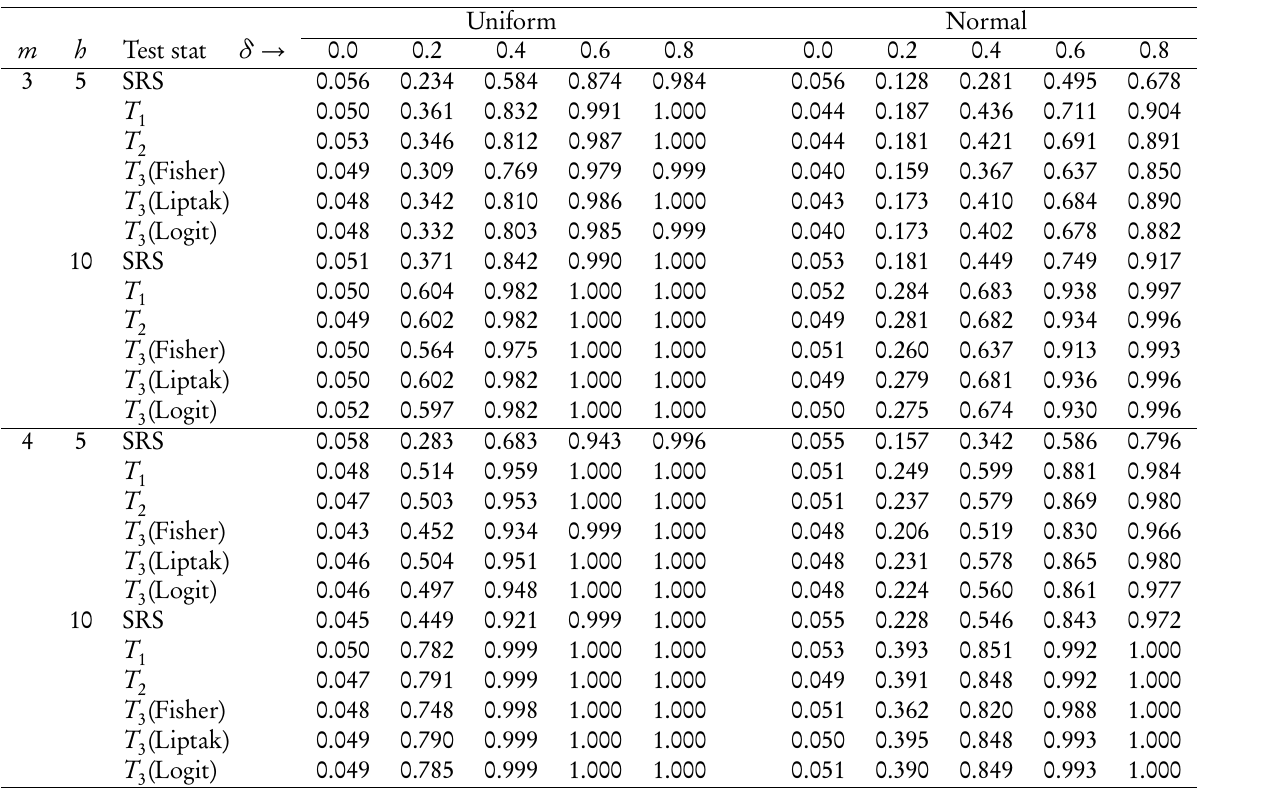
Empirical significance level and power from the simulation study – Uniform and normal